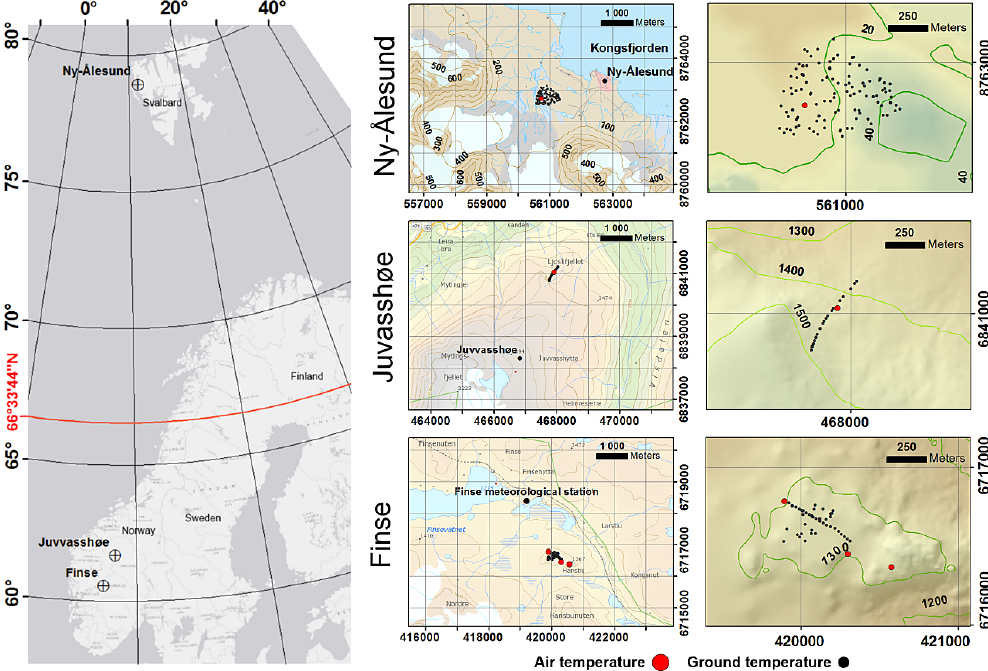
Figure 1. Study areas located along the gradient from continuous to sporadic permafrost in northern Europe: Ny-Ålesund, Svalbard; Juvvasshøe, Jotunheimen, southern Norway; Finse, Hardangervidda, southern Norway. Right column: distribution pattern of ground sur-